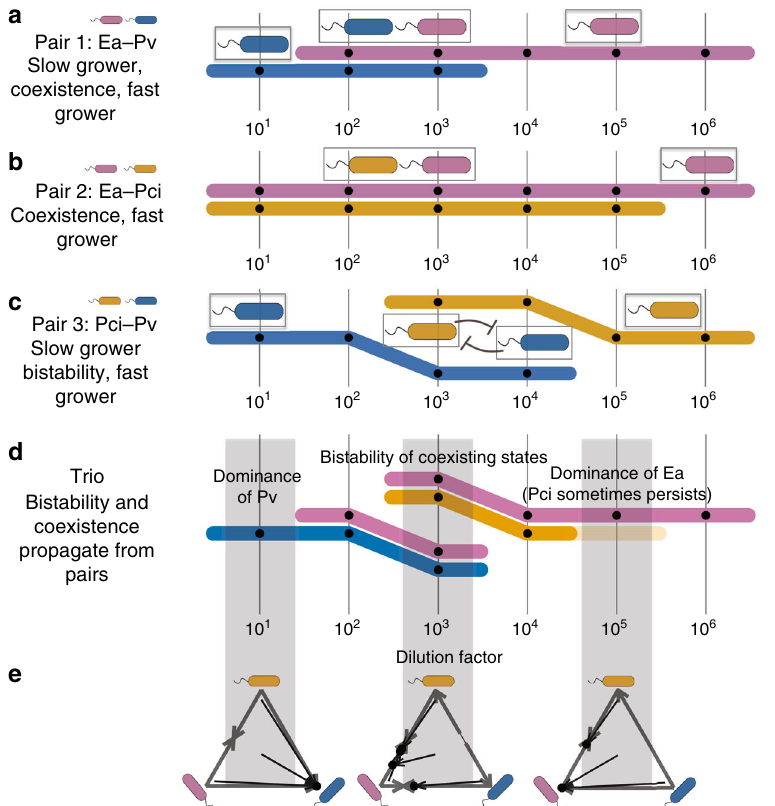
Fig. 5 Coexistence and bistability propagate from pair to trio, as predicted by assembly rules. a – c Subway maps show pairwise outcome trajectories across changing dilution factor (DF), as explained in Figs. 1 and 3. The fast grower ’ s line is always plotted above the slow grower ’ s line. Of the three pairs that make up the community Ea – Pci – Pv , two are coexisting ( a , b ) and one is bistable ( c ). d The pairwise assembly rules state that a species will survive in a community if it survives in all corresponding pairs. At DF 10, Ea and Pci coexist, but both are excluded by Pv . The rules correctly predict that Pv will dominate in the trio. Because both species can be excluded in a bistable pair, a bistable pairwise outcome propagates to the trio as more than one allowed state. Each of the bistable species can be seen separately coexisting with Ea at DF 10 3 , as they do in pairs. The assembly rules failed at DF 10 5 for three out of four starting conditions: Pci usually goes extinct when it should coexist with Ea . e Three-species competition results are shown in simplex plots. Arrows begin and end at initial and fi nal fractions, respectively. Edges represent pairwise results, and black dots represent trio results